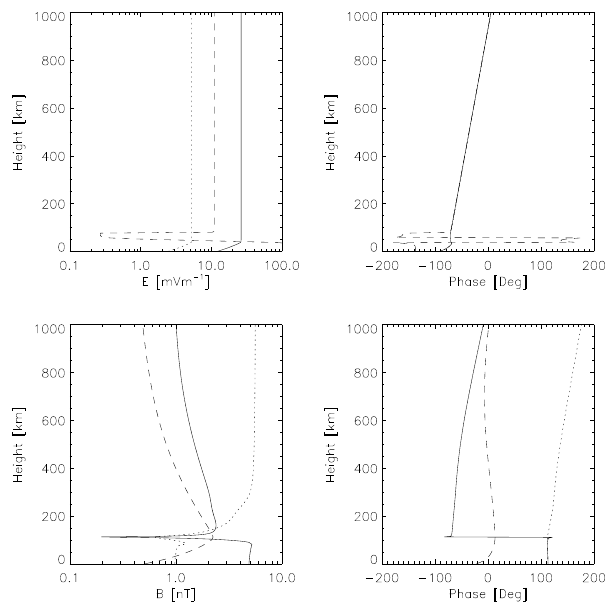
Fig. 3. ULF wave fields at L=2.4 for early morning (06:00LT) win- ter (North Hemisphere). The solid lines are the X (north-south), the dotted lines are the Y (east-west) and the dashed lines are the Z (ver- tical) ULF field components. The values for the ULF wave model were f =15mHz, k x = 3 . 5 × 10 − 6 m − 1 , k y = 7 . 0 × 10 − 7 m − 1 with an incident shear Alfv´en mode at 1000km